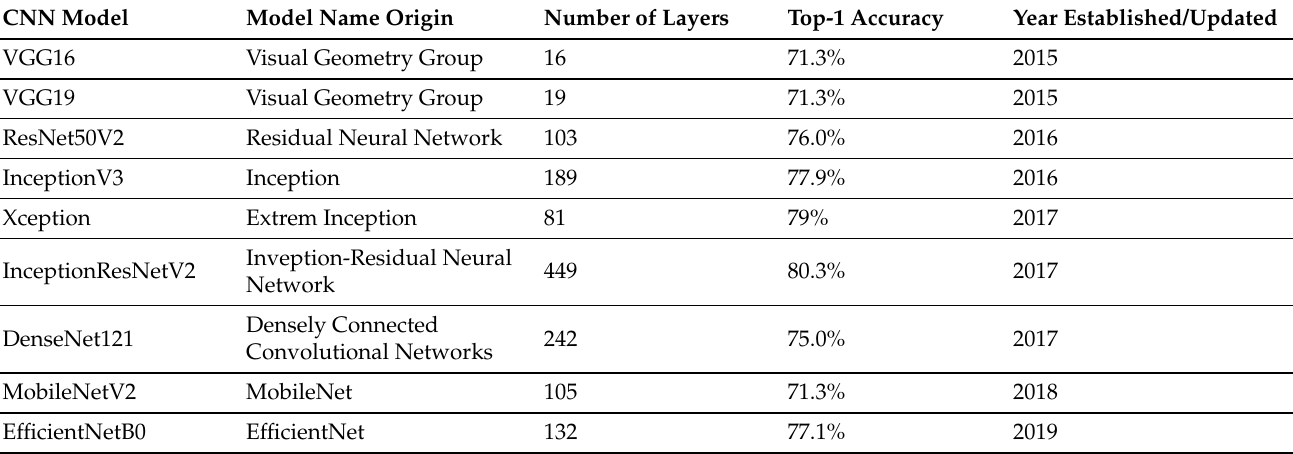
Table 2. Pre-trained